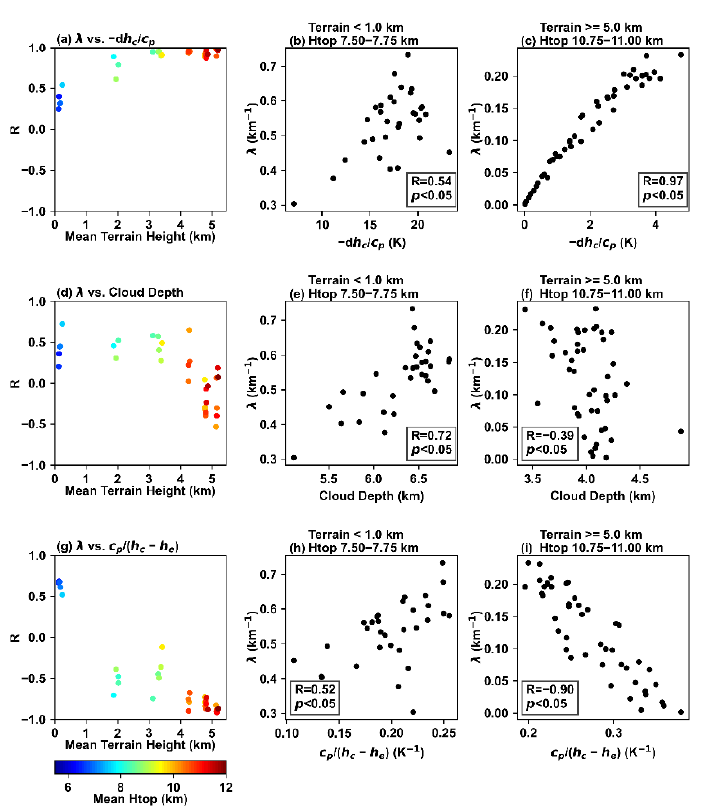
Figure 6. The correlation coefficients (R) of entrainment rate ( λ ; units: km − 1 ) with the difference in in-cloud moist static energy between the cloud base and top (Panel a ; represented by − d h c / c p ; units: K; c p is the isobaric specific heat of dry air), cloud depth (Panel d ; units: km), and the reciprocal of the difference between in-cloud and environmental moist static energy (Panel g ; represented by c p /( h c − h e ); units: K − 1 ) in the different cloud groups, and the relationships between λ and − d h c / c p (Panels b , c ), cloud depth (Panels e , f ), and c p /( h c − h e ) (Panels h , i ) in the representative cloud groups; the color bar denotes the mean cloud top height in each group.